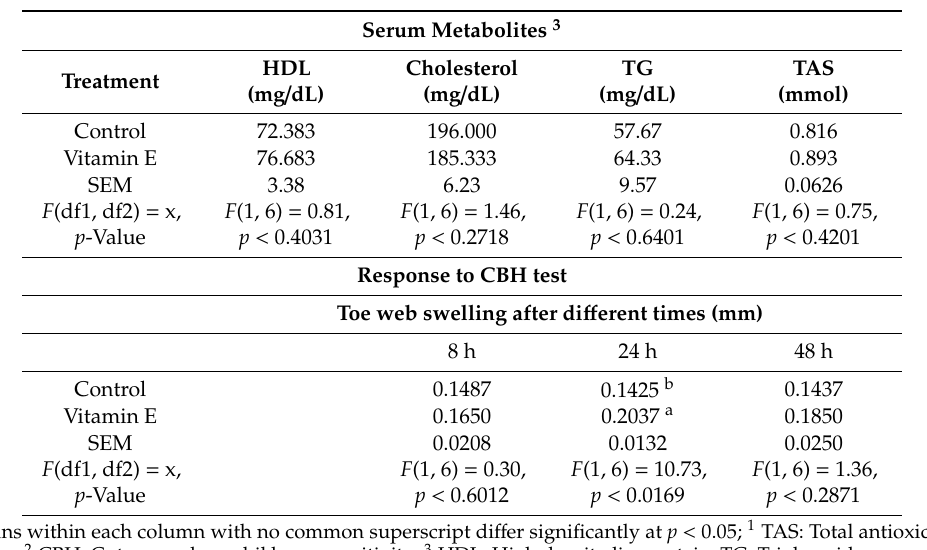
Table 3. E ff ect of dietary vitamin E supplementation on serum TAS 1 , cholesterol, triglyceride, and response to the CBH 2 test of male geese.